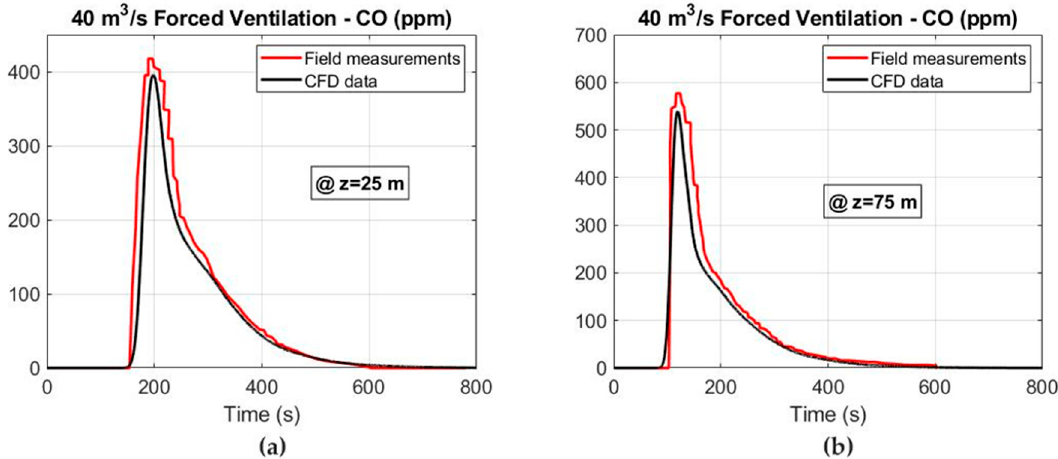
Figure 10. CFD results and field measurements considering an airflow of 40 m 3 s − 1 under the forced ventilation mode: ( a ) CO concentration at Z = 25 m and ( b ) CO concentration at Z = 75 m.